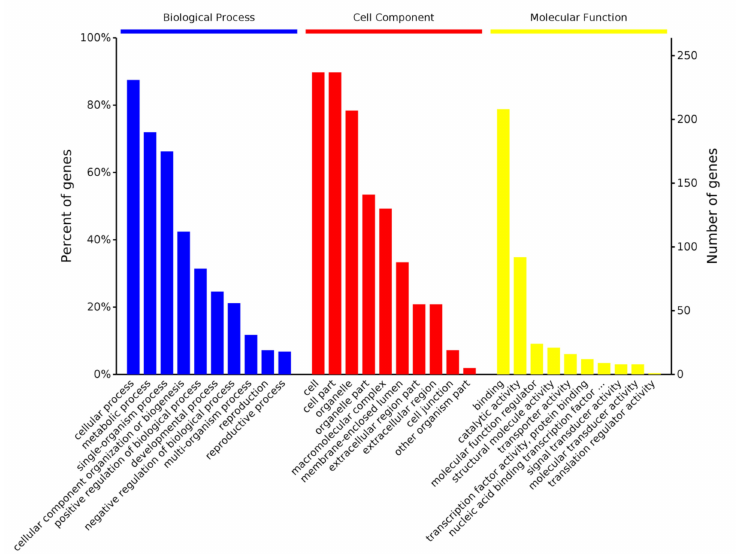
Figure 3. Gene ontology (GO) analysis based on the interaction between cell protein and MGF360-9L. Using Cytoscape v.3.7.1 and ClueGO software plug-in, the GO distributions of all proteins were divided into three types. The y were shown for significantly enriched terms based on biological process, molecular function (MF), and cellular component at p < 0.05.